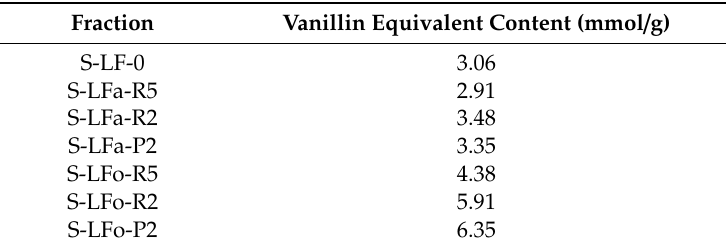
Table 5. Results of the determination of phenolic hydroxyl groups expressed as vanillin equivalents in the lignin fractions recovered from aqueous and organic processes applied on S-LF-0 (expressed in mmol / g) in the dry lignin. Estimated standard errors ± 0.2 mmol / g vanillin equivalent (1 σ , from calibration data).